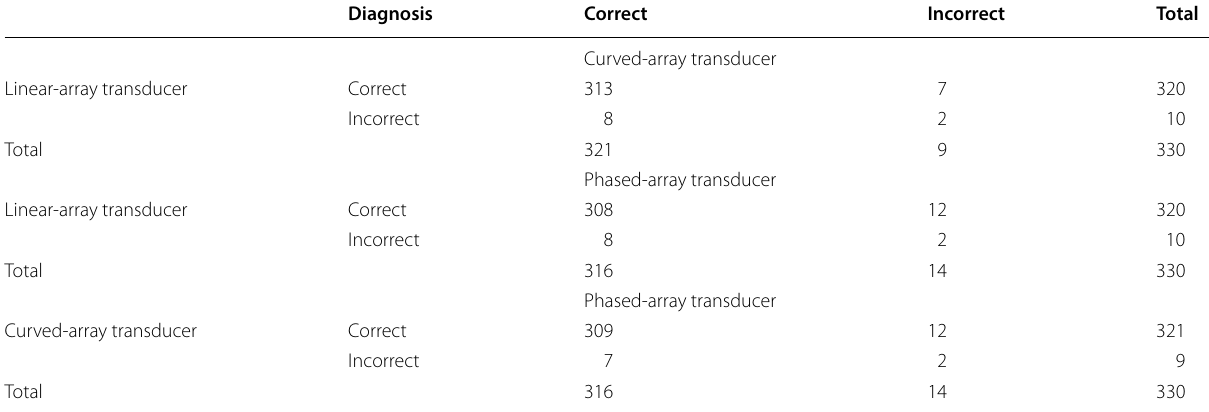
Table 1 Cross tabulation of the number of correct and incorrect diagnoses compared between transducers Diagnosis